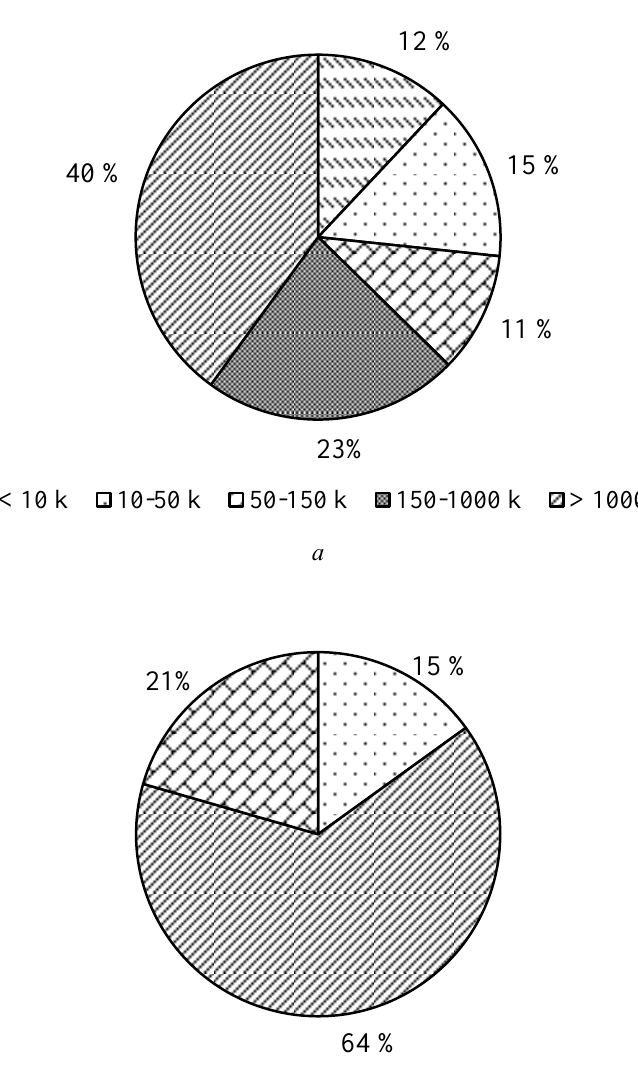
Fig. 1. Distribution of respondents by indicators: а – the population in the settlements where their pharmacies are situat- ed; b – the number of visitors that are served